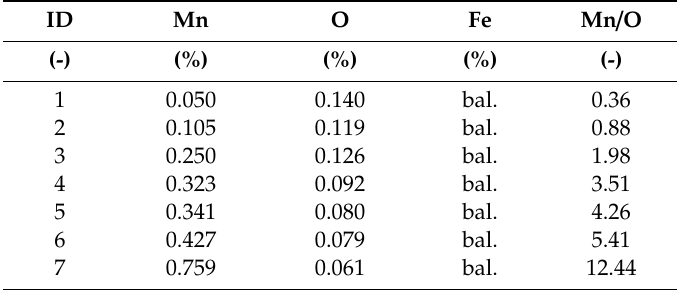
Table 1. Chemical compositions of Samples 1–7 in wt %.